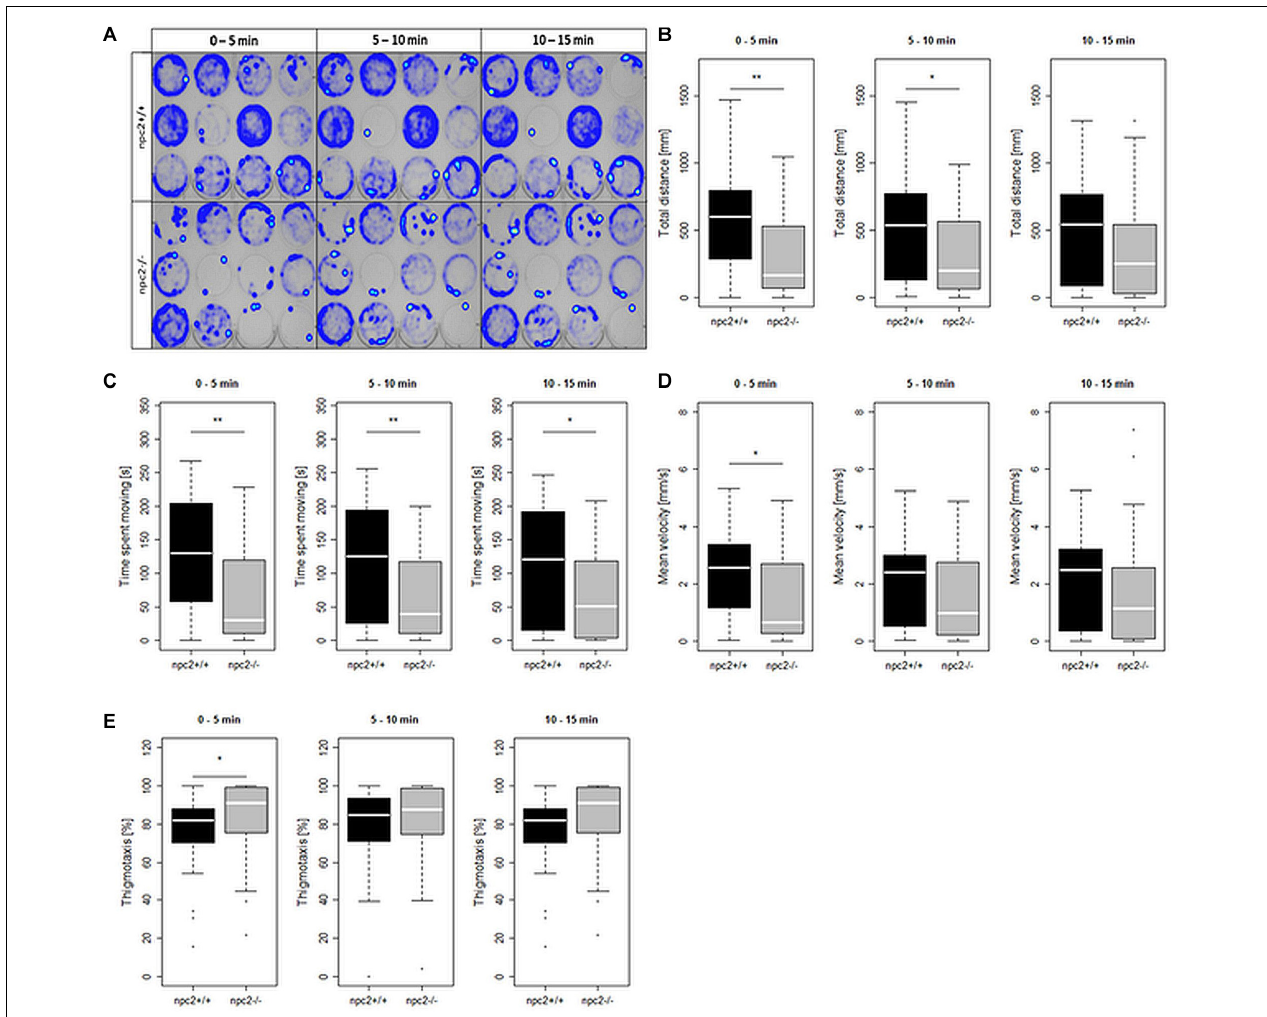
FIGURE 4 | Decrease in mobility and increase in thigmotaxis in npc2 − / − larvae. (A) Heatmaps of mean traces of npc2 + / + and npc2 − / − larvae during each 5 min period. (B–E) Boxplots of total distance traveled, time spent moving, mean velocity, and thigmotaxis in npc2 + / + and npc2 − / − larvae. (E) * p < 0.05 and ** p <